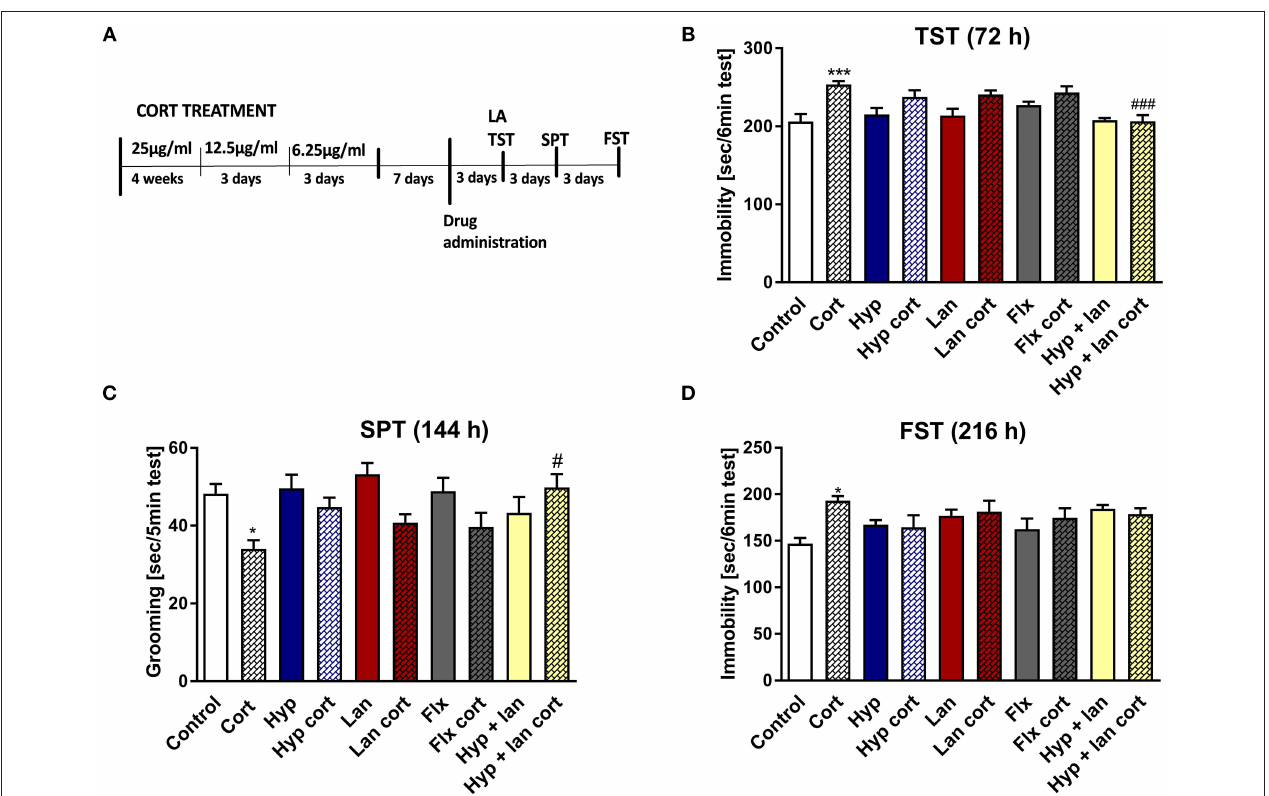
FIGURE 2 | The effect of the administration of single doses of hyperforin (Hyp), lanicemine (Lan), fluoxetine (Flx), and hyperforin + lanicemine (Hyp + Lan) on behavioral disturbances induced by chronic corticosterone (Cort) treatment n = 9–11. Single doses of the following drugs: hyperforin (2.5 mg/kg; i.p .), lanicemine